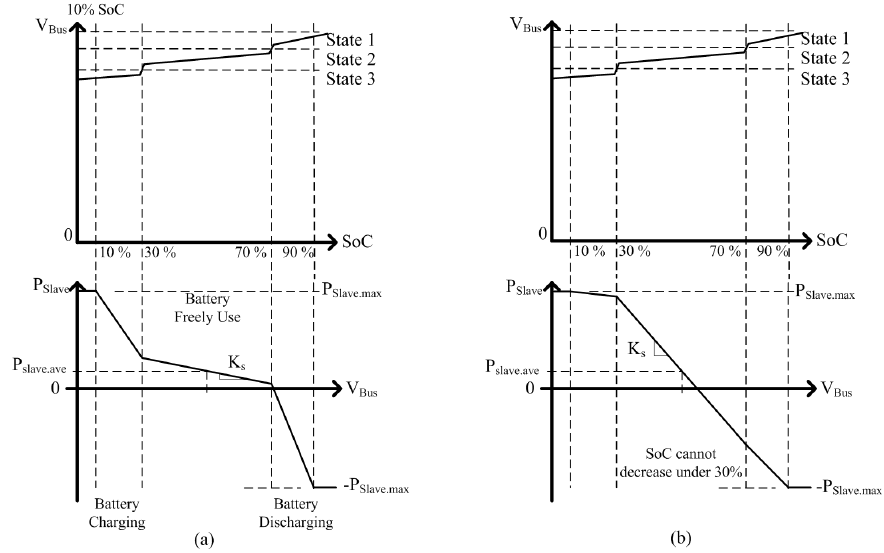
Figure 3. Nonlinear K m and K s curve designs of the proposed master–slave control method using ( a ) small K s and ( b ) large K s cases.